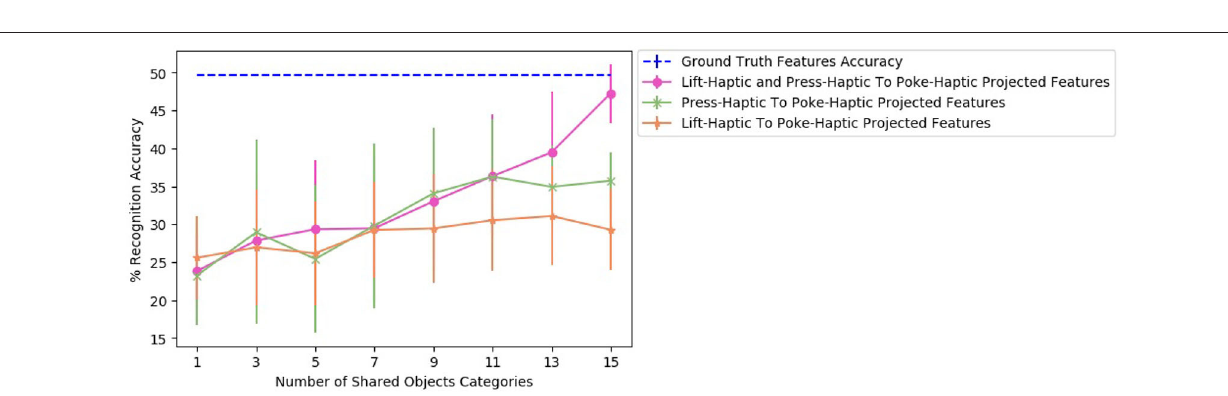
FIGURE 16 | Accuracy achieved by the projected features of the target robot for different number of shared objects for β -VAE lift-haptic and press-haptic to poke-haptic projection, β -VED lift-haptic to poke-haptic projection and β -VED press-haptic to poke-haptic